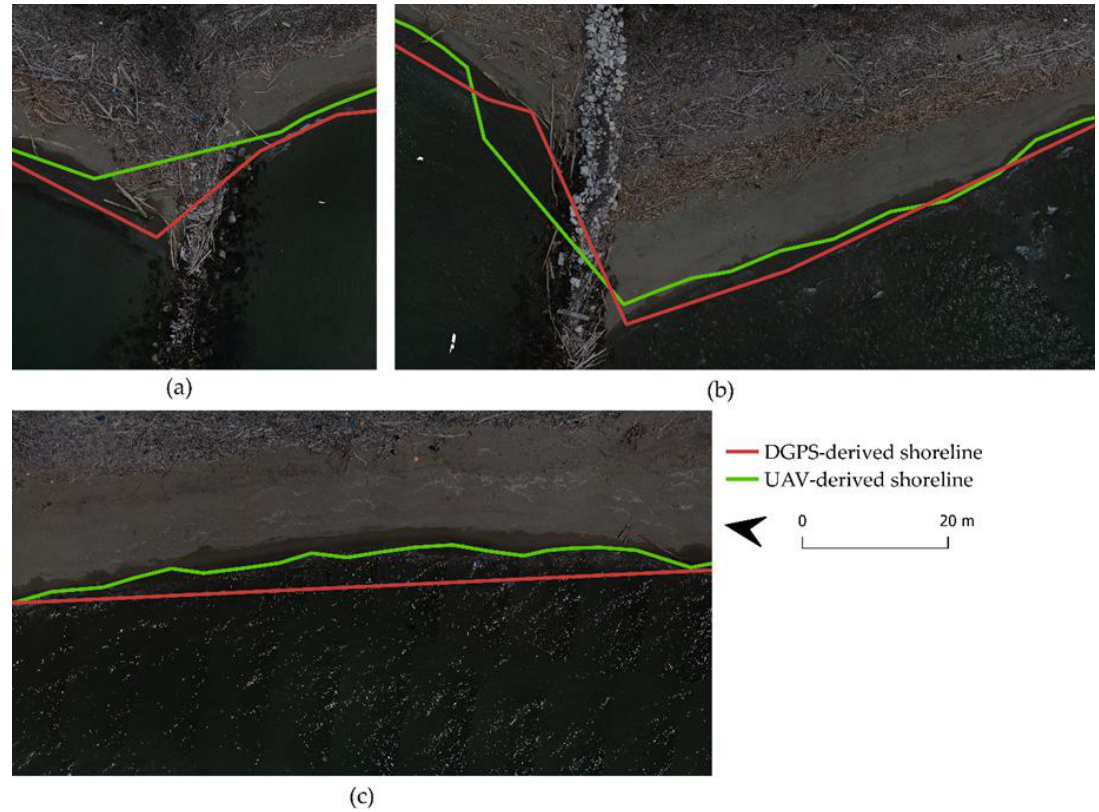
Figure 4. Shorelines derived from DGPS points (line red) and from UAV image processing (green line). ( a ) The DGPS-derived shoreline (red line) approximates the real shoreline better than the UAV-derived shoreline (green line); ( b ) the two shorelines approximate the real shoreline better alternating; ( c ) the UAV-derived shoreline (green line) approximates the real shoreline better than the DGPS-derived shoreline (red line).